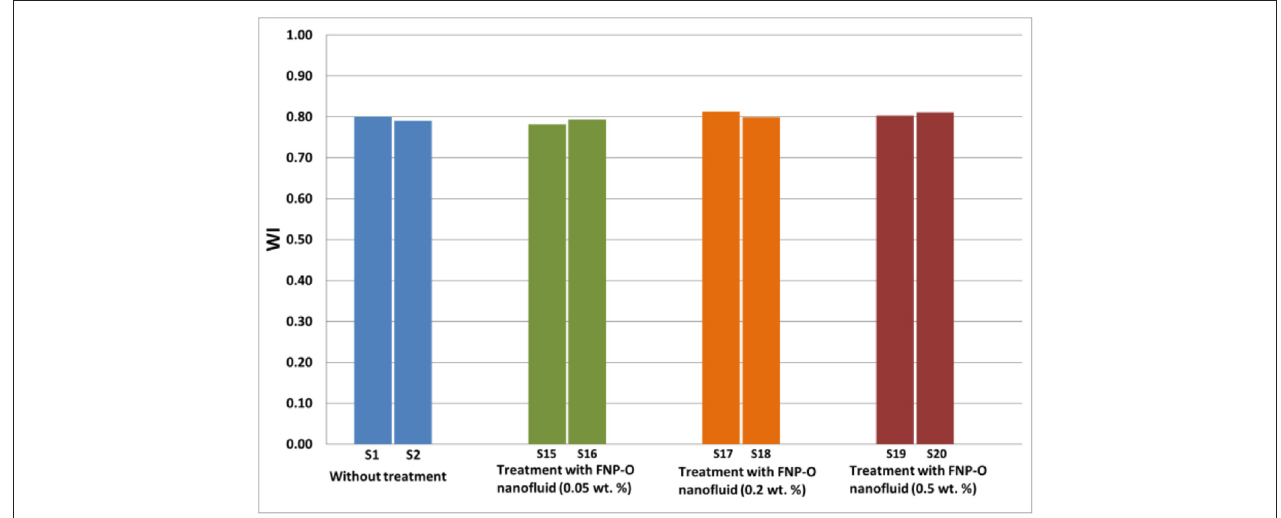
FIGURE 9 | Wettability index for core plugs treated with